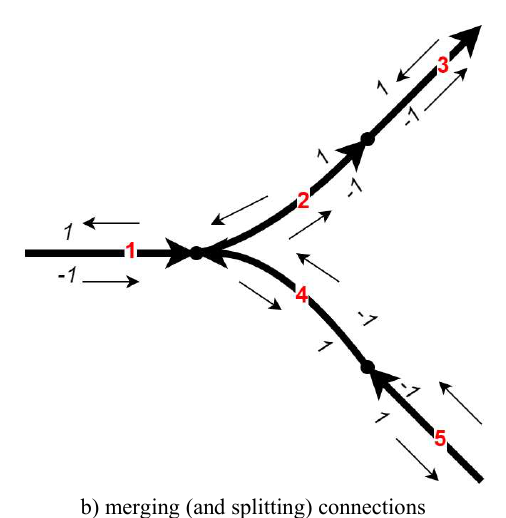
Figure 4. Splitting and merging connection cases The corresponding topological tables for the two examples